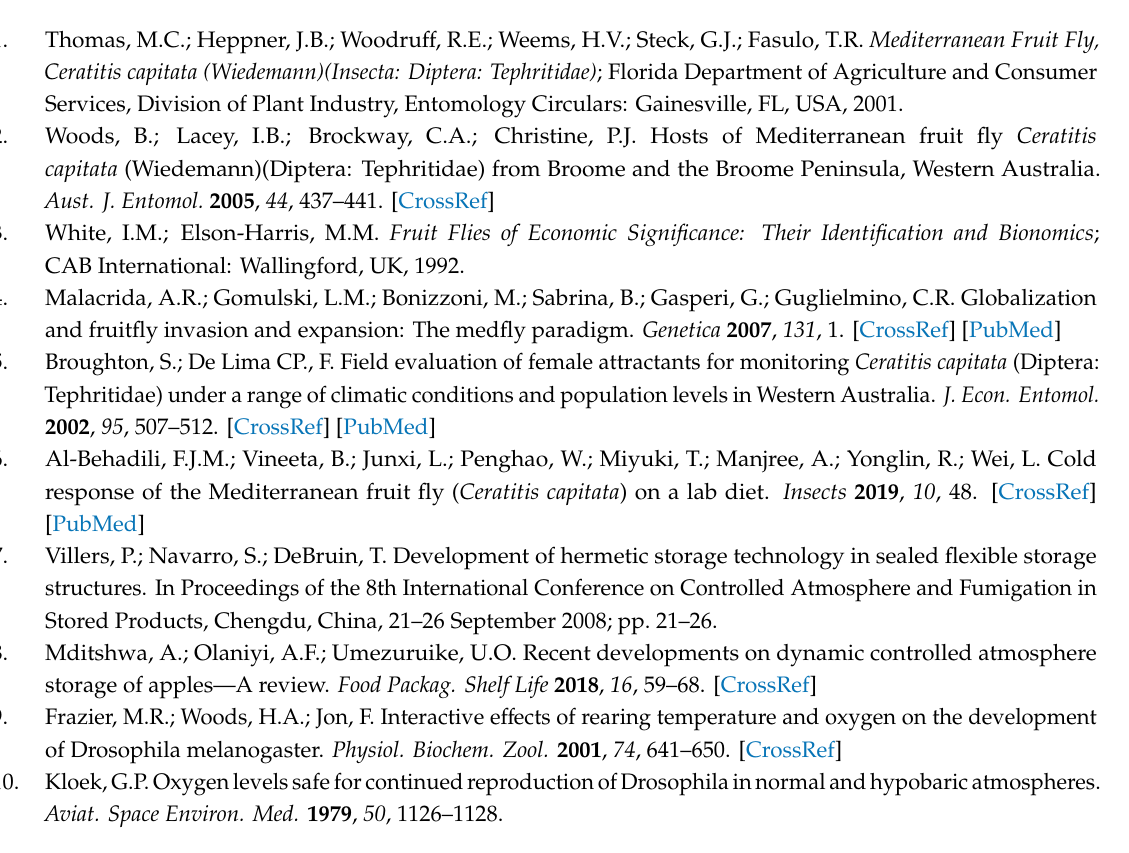
Table S1: Experimental design for the control of a medfly on a carrot diet at di ff erent O 2 concentrations and di ff erent exposure times at 25 ◦ C ± 1 with 70–75% RH. Table S2: Two di ff erent models were used in the C. capitate mortality data analysis. Table S3: ANOVA table of low-oxygen concentrations, exposure times, stages and sex ratio of Ceratitis. Capitata. Figure S1: The female percentage (%) of survived adults during the first four days of 0.5% and 5.0% low-oxygen treatments. Error bar means standard error. An ANOVA single factor test was used to compare sex ratios, p >